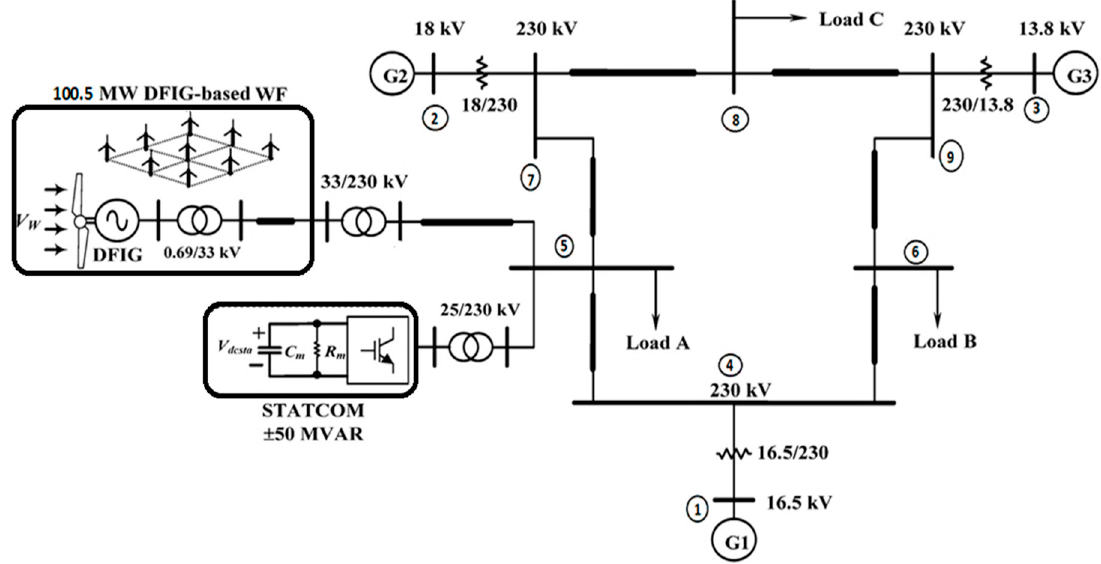
Figure 1. Observe system setup.